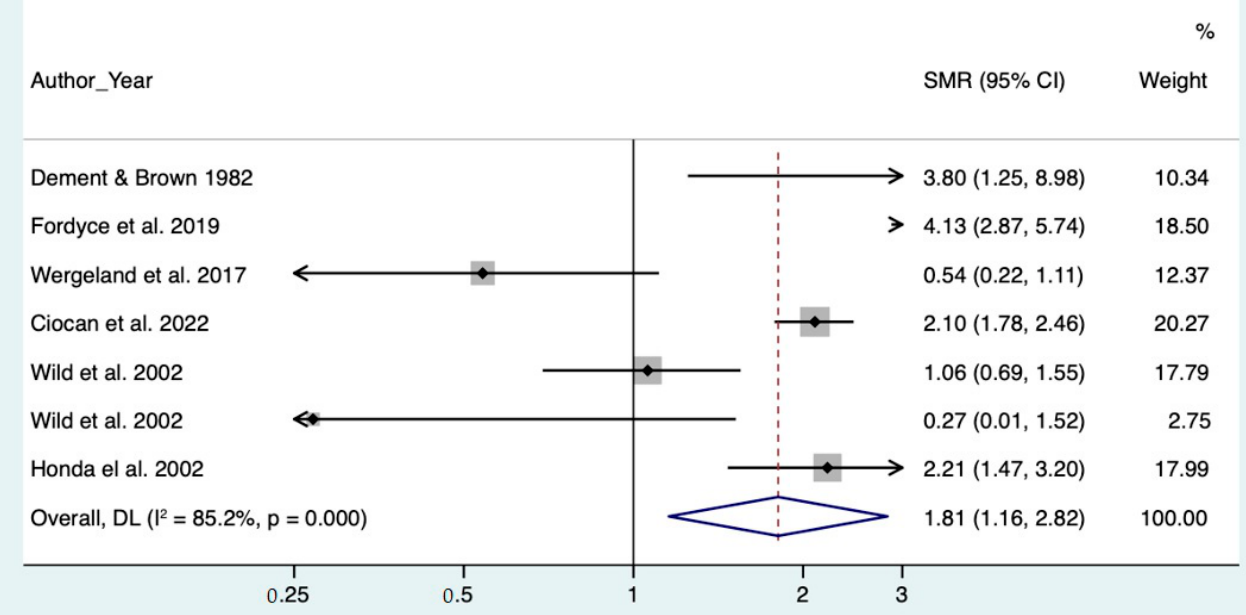
Figure 3. Meta analysis of non-malignant respiratory diseases. [11–13,15,26,27]